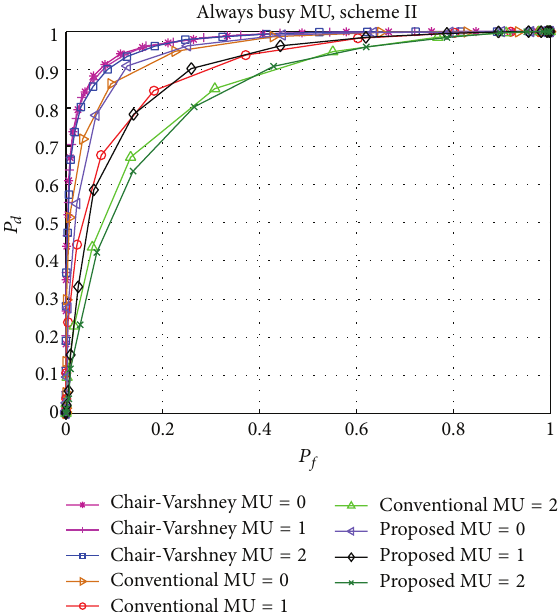
Figure 6: Performance comparison of the Chair-Varshney, conven- tional CSS, and proposed scheme II with always busy (AB) MUs.